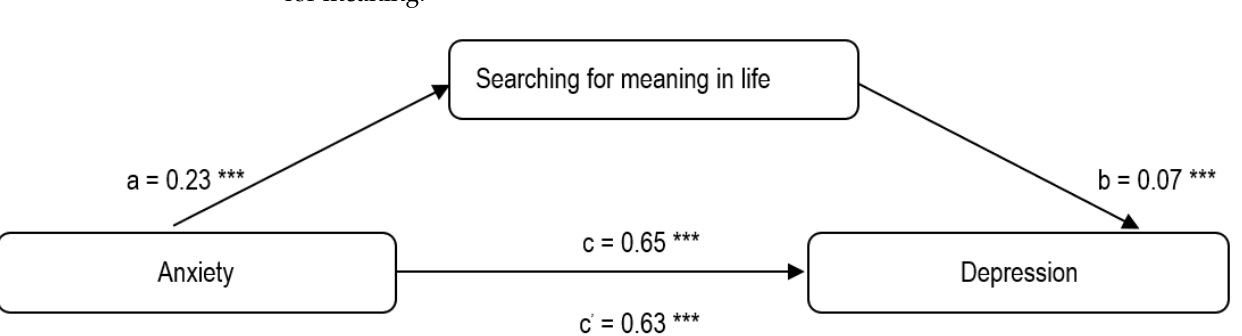
Figure 1. Results of mediation analysis of presence of meaning in life in the relationship between anxiety and depression. *** p < 0.001 .